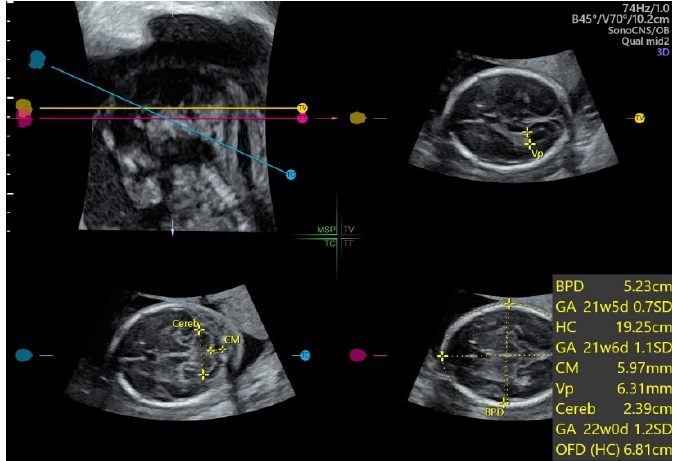
Figure 14. SonoCNS, after volume acquisition of the fetal brain at biparietal diameter plane at 21 weeks gestation, showing auto measurement of biparietal diameter (BPD), head circumference (HC), atrium of the posterior horn of the lateral ventricle (Vp), transcerebellar diameter (TCD), and cisterna magnum (CM).